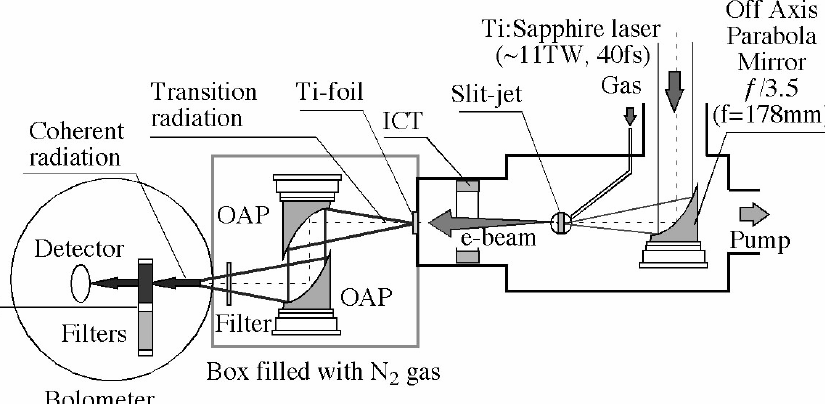
FIG. 1. Experimental setup for bunch duration measurement. Transition radiation emitted from Ti foil is detected by a